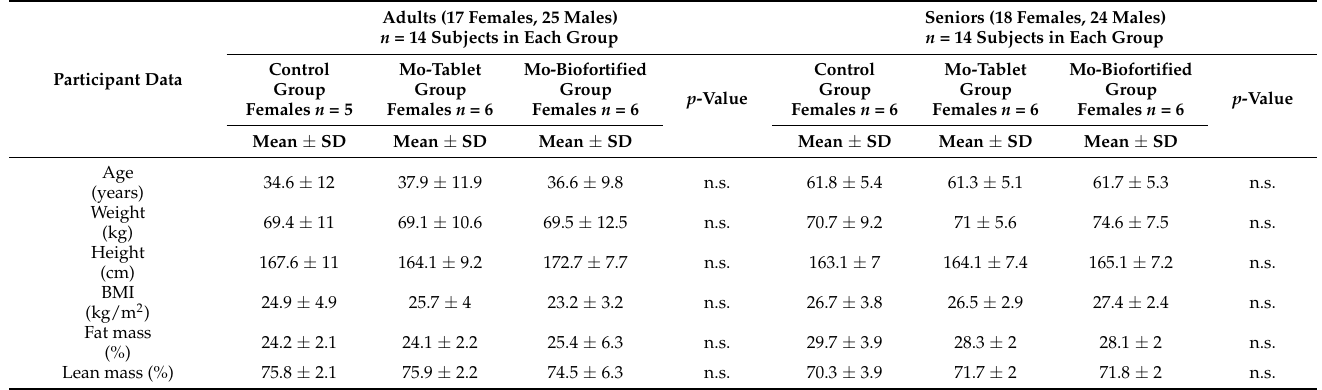
Table 2. Characteristics of participants at the beginning of the study (baseline, T0). Values are indicated as means ± standard deviations